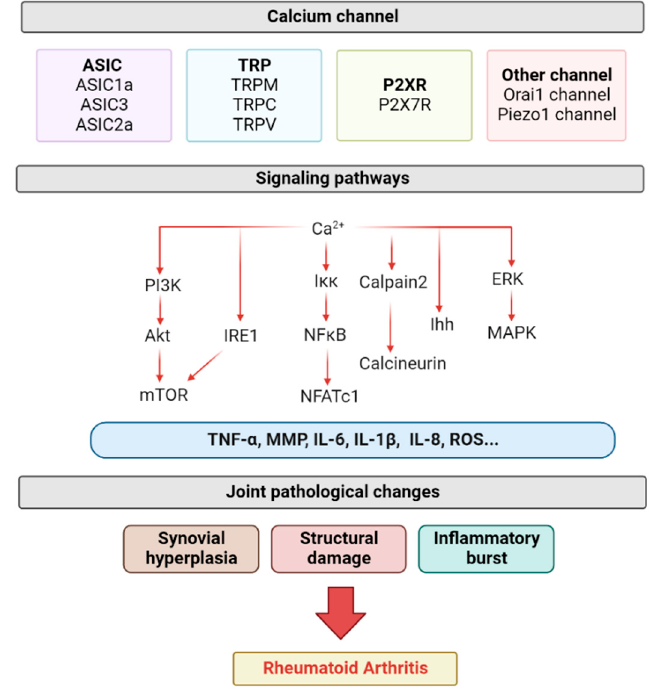
Figure 1. The role of calcium-permeable channels in the pathogenesis of RA. ASIC, TRP, P2X7R, Orai1 and Piezo1 channels regulate a variety of calcium-ion-related signaling pathways, which, in turn, lead to changes in related inflammatory factors, ultimately leading to synovitis, structural damage, and inflammatory outbreaks (created with Biorender.com, access date 29 July 2022).